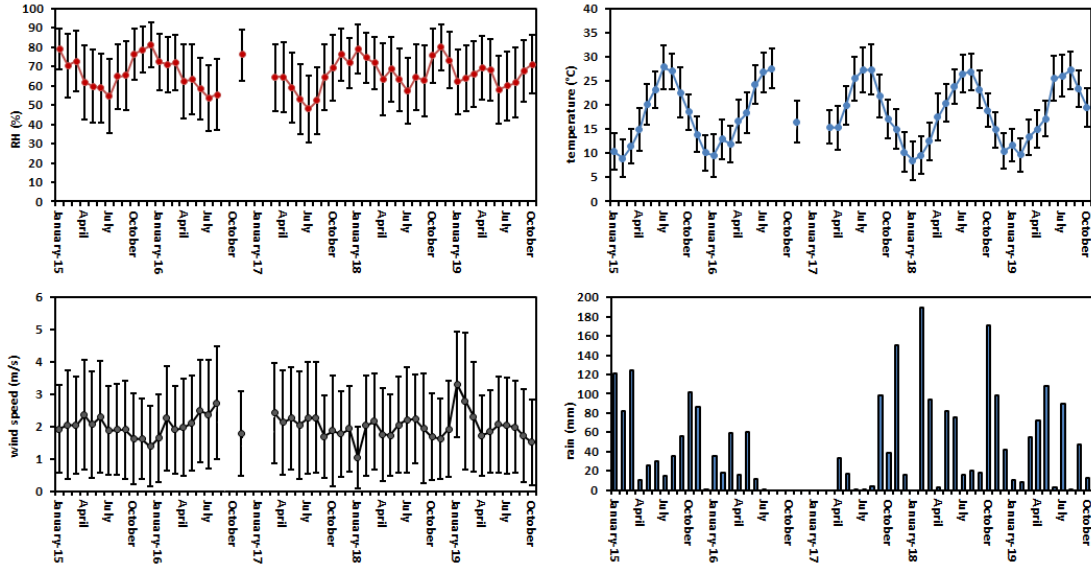
Figure 8. Monthly variations in temperature, relative humidity, wind speed, and rain accumulation observed in Lecce during the five-year measurements. Vertical bars represent the standard deviations.